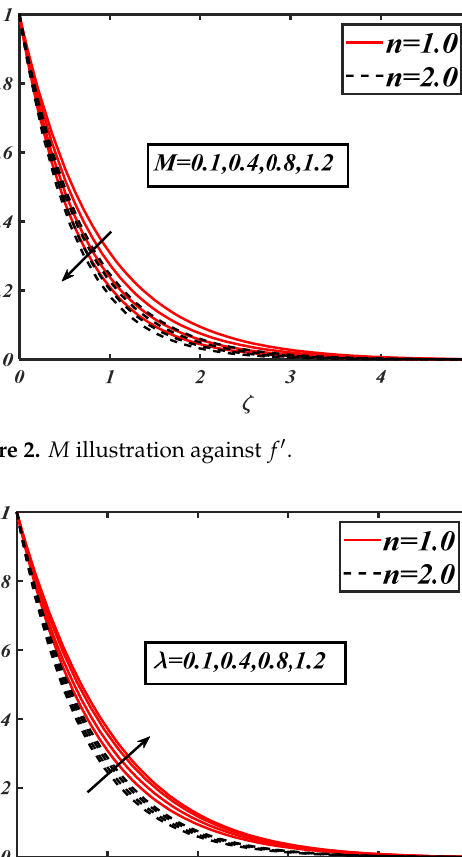
λ illustration against f